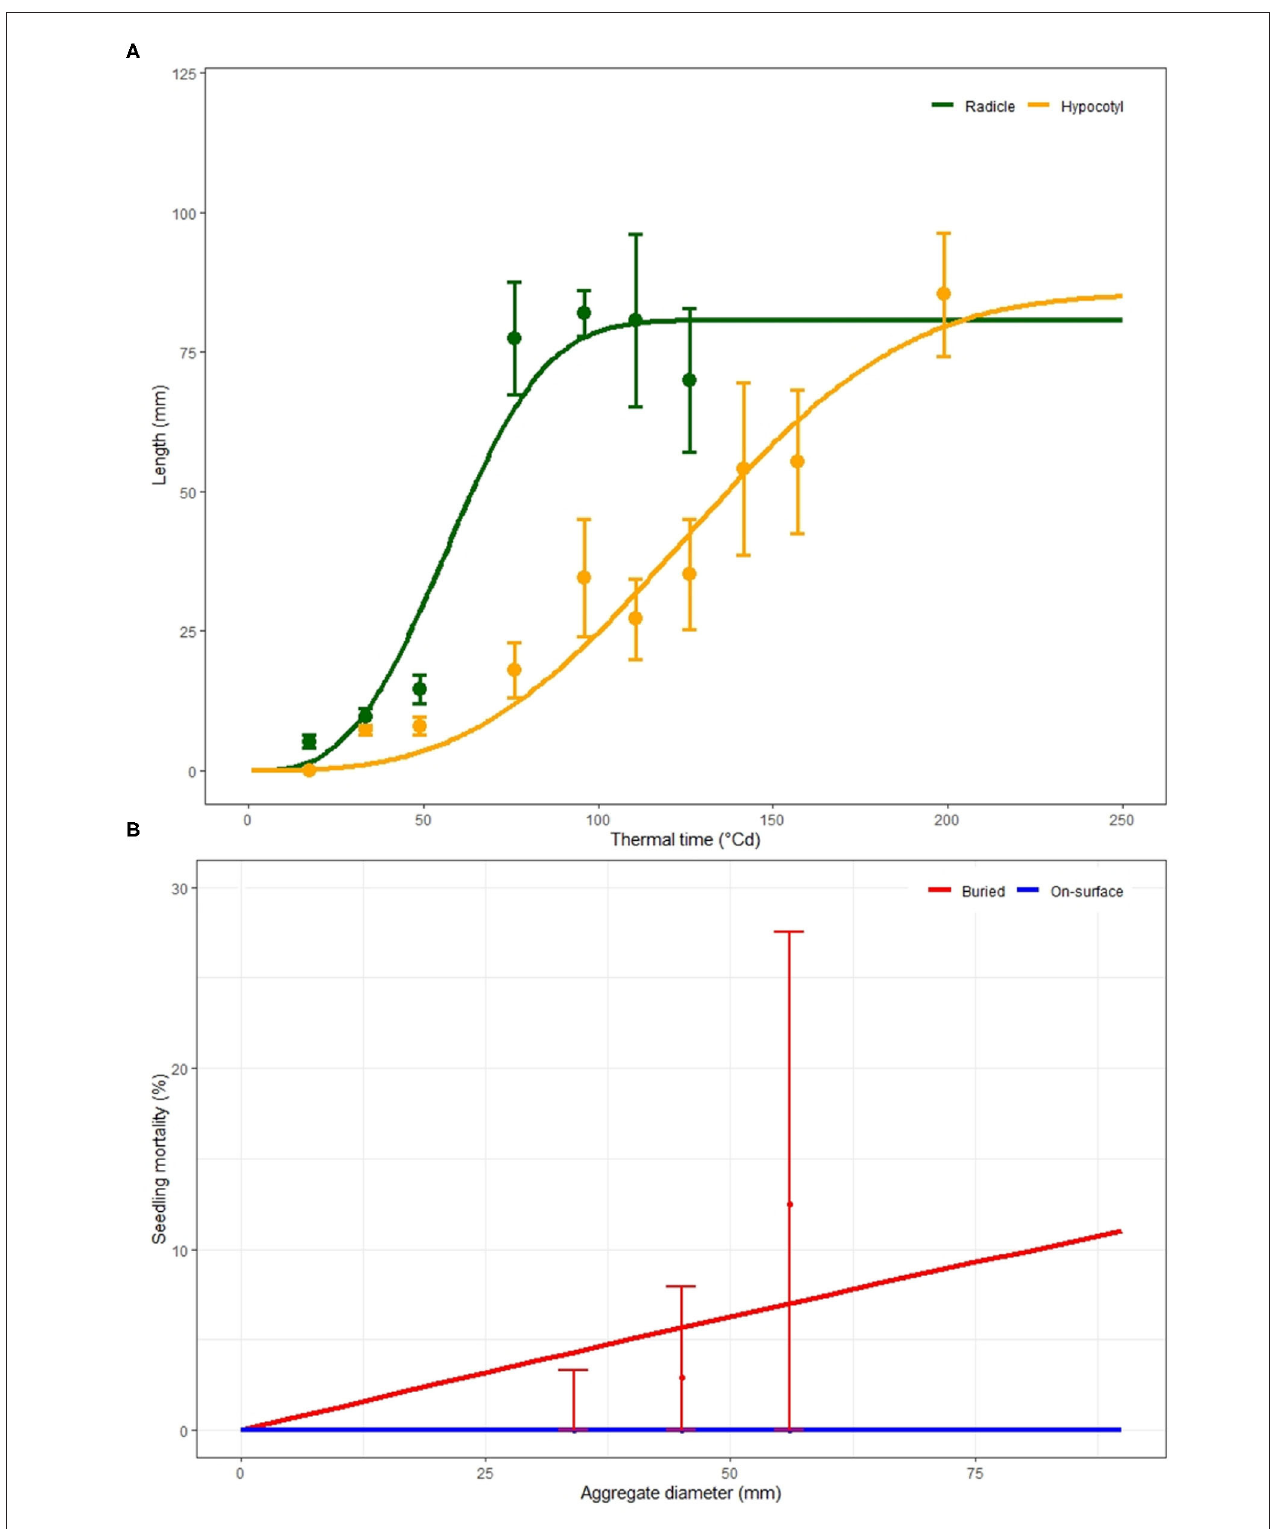
FIGURE 3 | Mean rates of the hypocotyl and radicle elongation (A) , and seedling mortality under different soil aggregate sizes and spatial distribution (B) of hybrid oilseed sunflower (cv. RGT Lluis) in relation to cumulative degree-days ( ◦ Cd) under growth chamber conditions in 2020. Vertical bars reported in the figures represent confidence